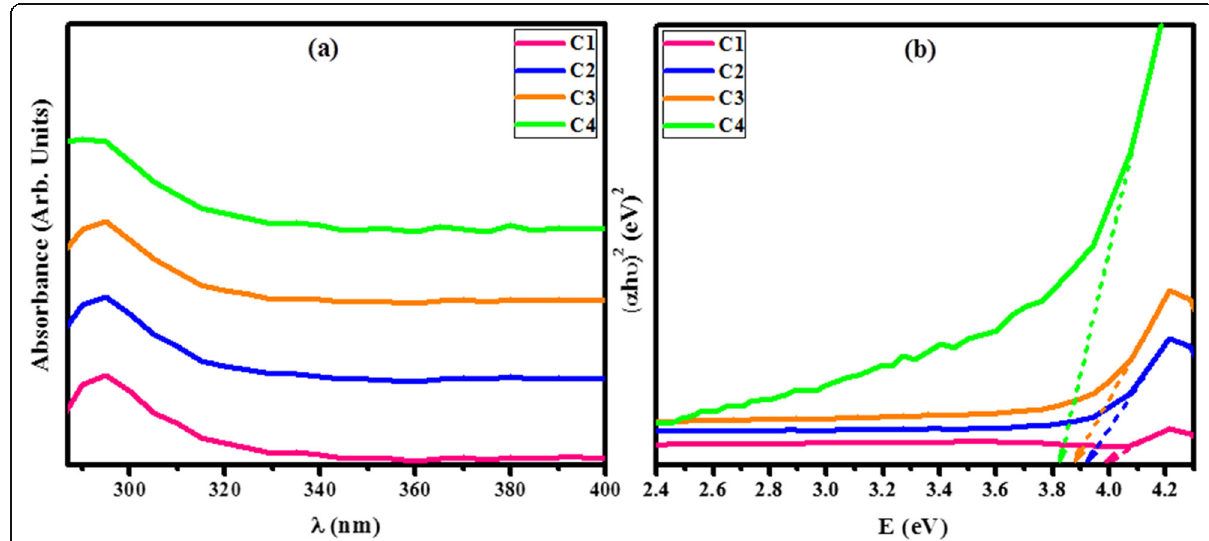
Fig. 7 a UV-Vis spectra. b Band gap of C1, C2, C3, and C4